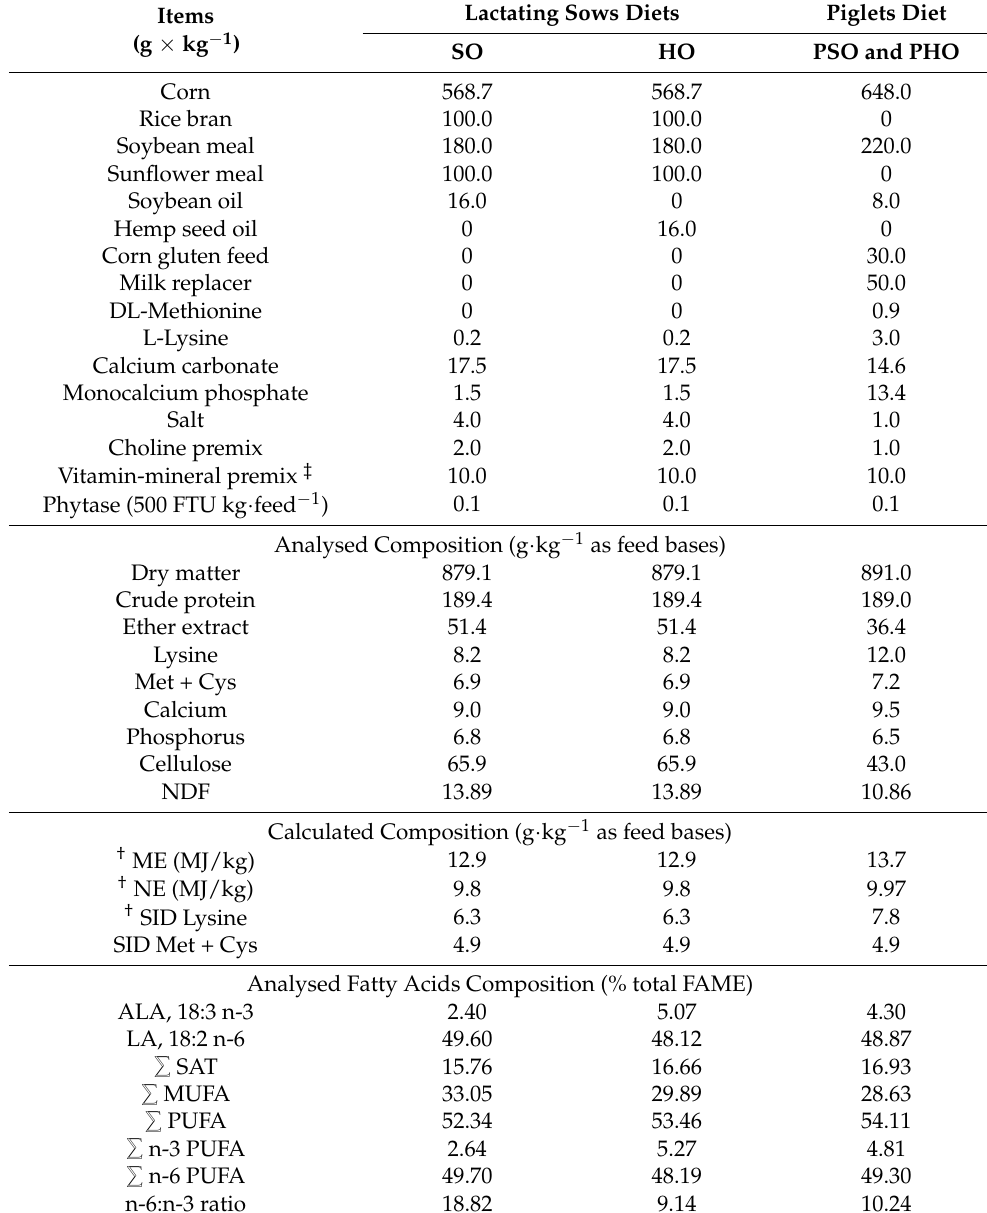
Abbreviations: lactating sows diets based on soybean oil (SO) and based on hemp seed oil (HO); suckling piglets ’ diet (PSO/PHO); FAME = fatty acid methyl esters; ALA = alpha linolenic acid; LA = linoleic acid; ⅀ SFA = total saturated fatty acids; ⅀ MUFA = total monounsaturated fatty acids; ⅀ PUFA = total polyunsaturated fatty acids; ⅀ SFA = 14:0 + 16:0 + 18:0 + 20:0; ⅀ MUFA = 16:1 + 18:1;